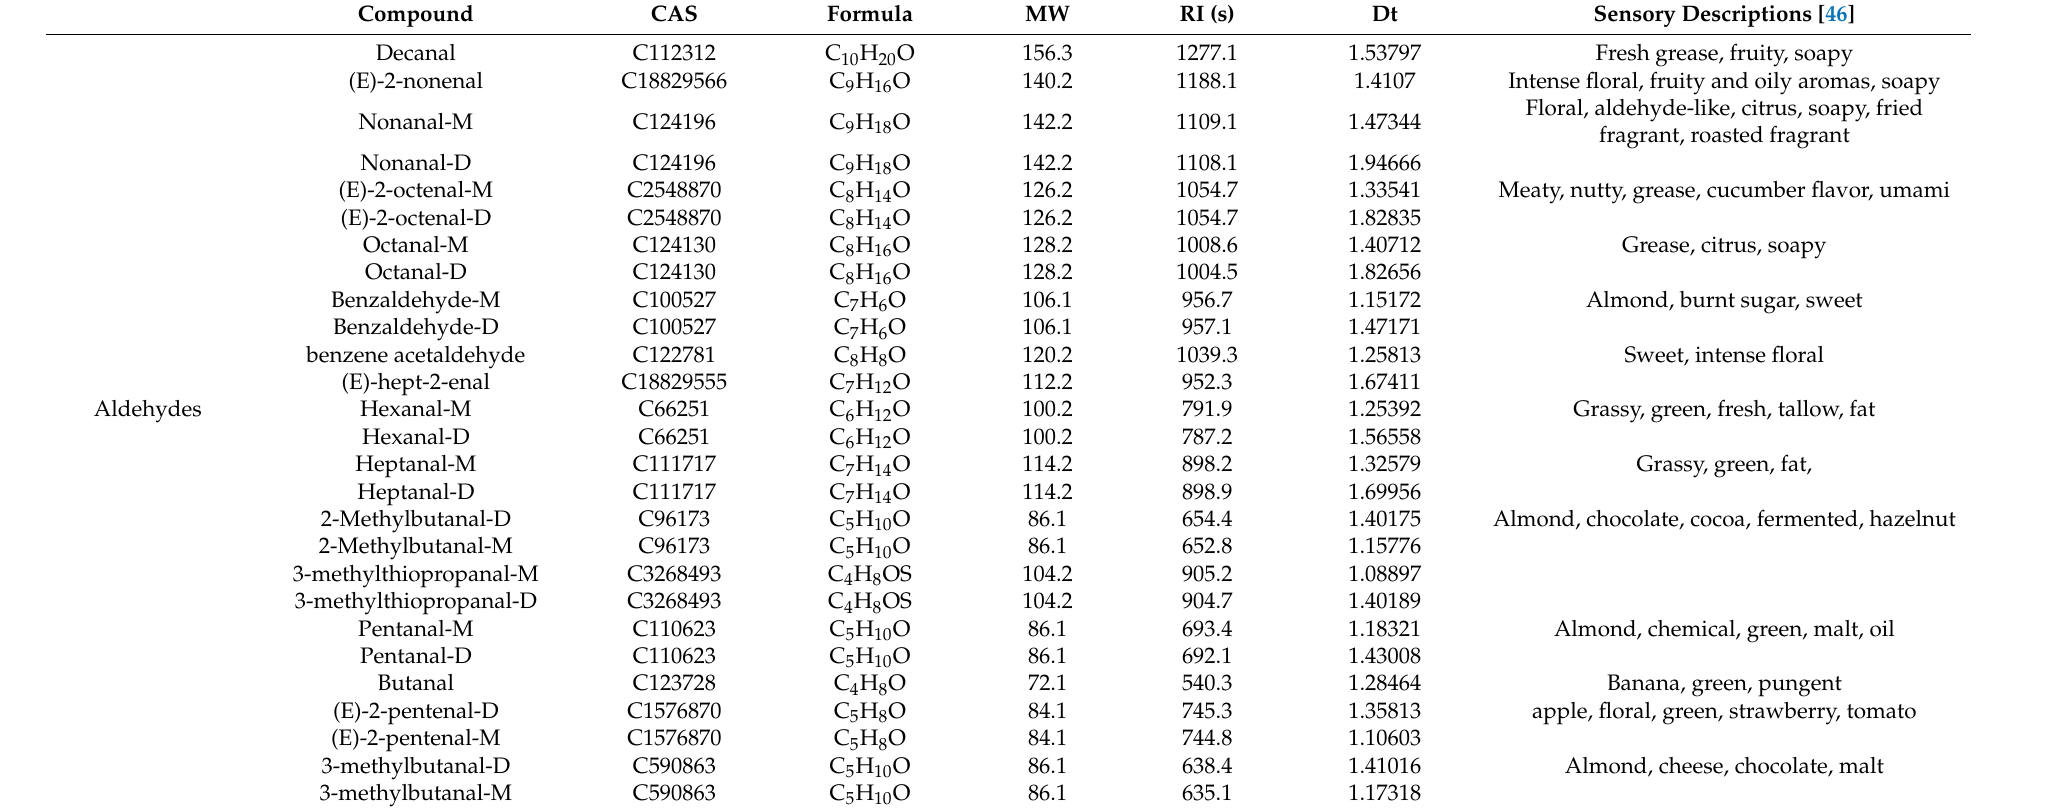
Table 3. Qualitative information on samples of Pingliang red beef processed using four cooking methods.